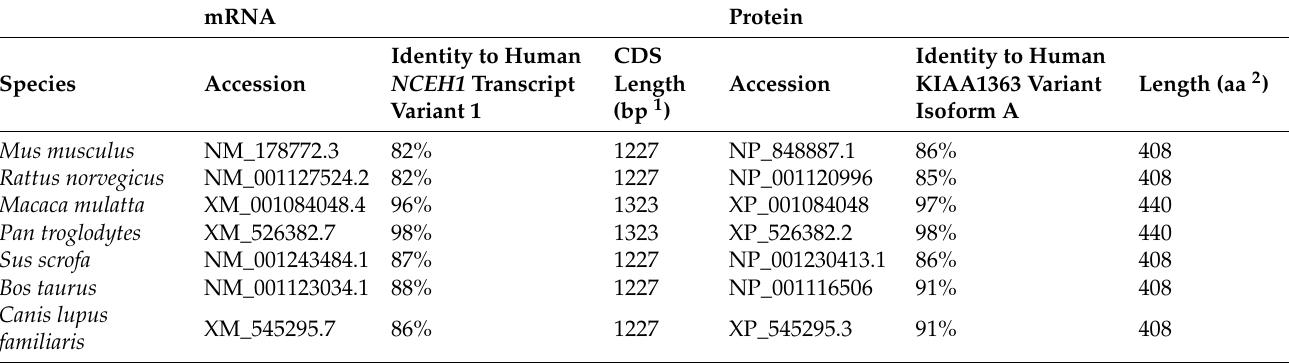
Table 1. KIAA1363